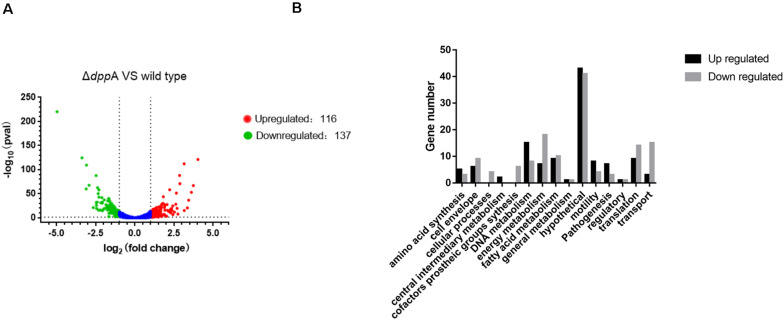
Differentially expressed genes between H. pylori 26695 and ΔdppA by RNA sequencing. (A) Volcano plot of gene expression in H. pylori 26695 and ΔdppA. The Y-axis represents -log10 (P-value), and X-axis represents log2 (fold change). Positive values represent genes upregulated in ΔdppA, while negative values represent genes downregulated in ΔdppA. The horizontal dashed line represents P = 0.05. Red dots represent those genes with expression in ΔdppA higher than wild type, with Log2 (fold change) > 1 and P < 0.05. Green dots represent genes with lower expression in ΔdppA compared with wild-type, with Log2 (fold change) < –1 and P < 0.05. (B) Functional annotation of genes differentially expressed in H. pylori 26,695 and ΔdppA. Black bars represent genes expressed higher in ΔdppA compared with wild type, while gray bars represent genes expressed lower in ΔdppA compared to wild type.